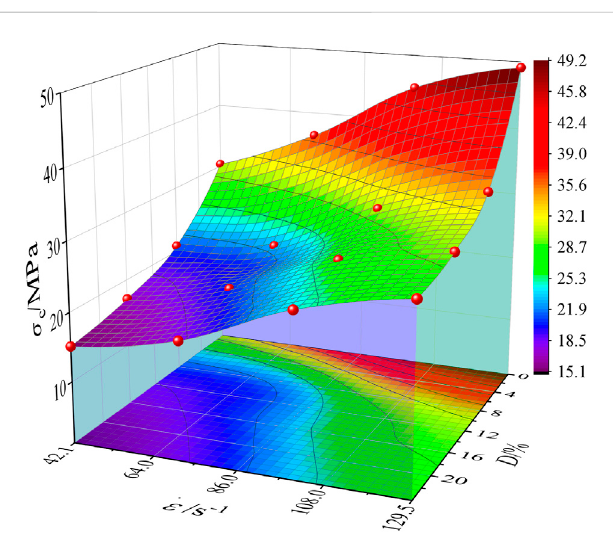
FIGURE 4 Coupling effect of initial damage and strain rate on dynamic peak